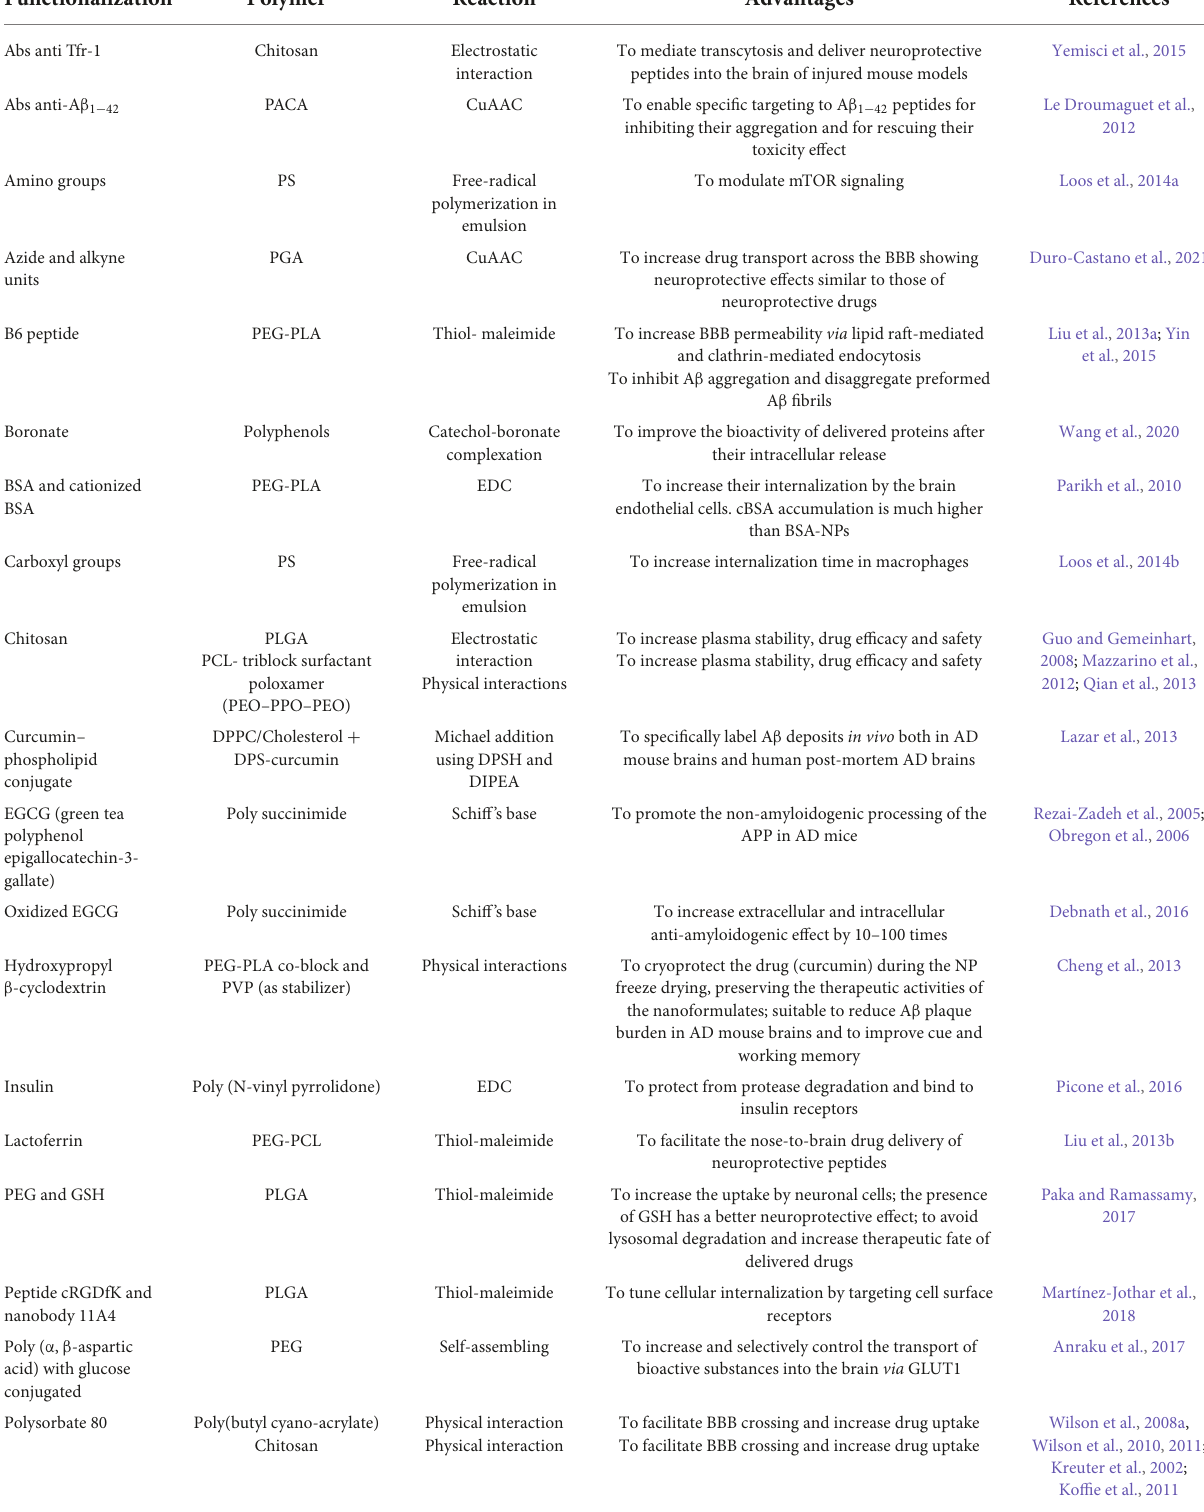
TABLE 1 Summary of functionalized polymeric NPs and their potential